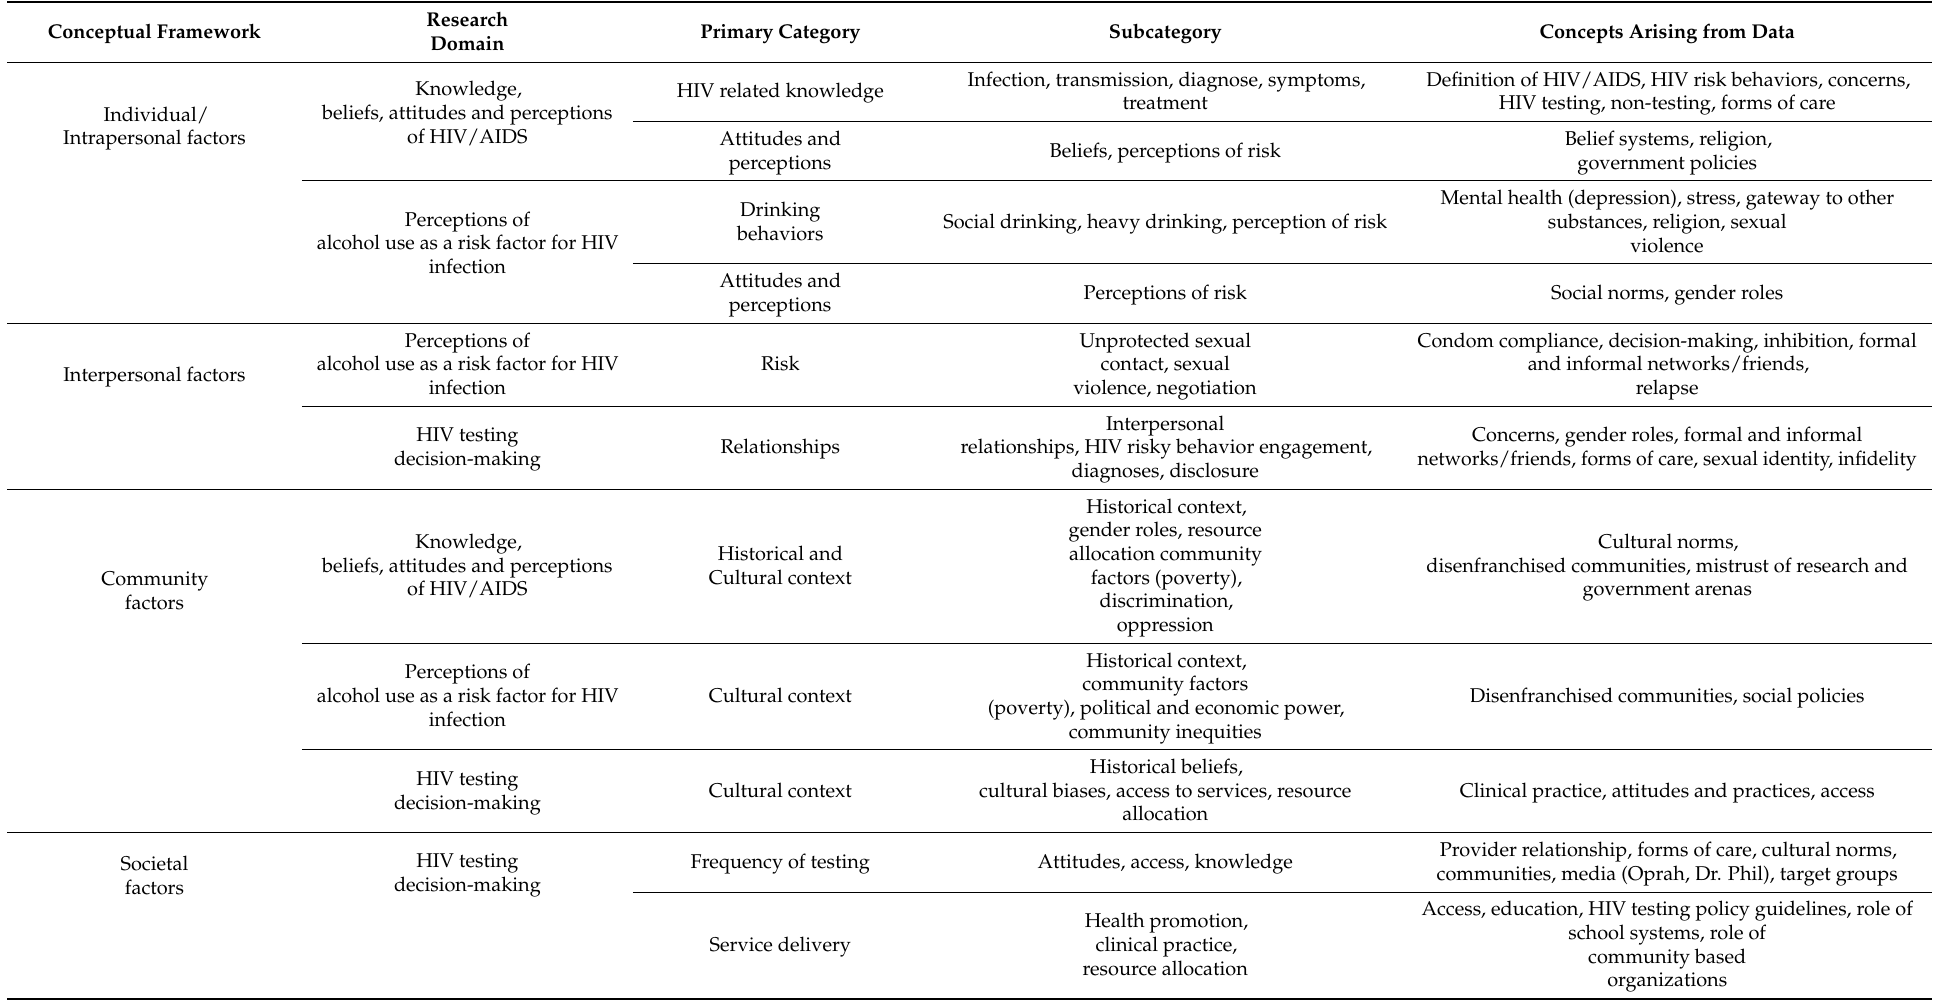
Table 1. Deductive and inductive approach to thematic analysis using the socioecological